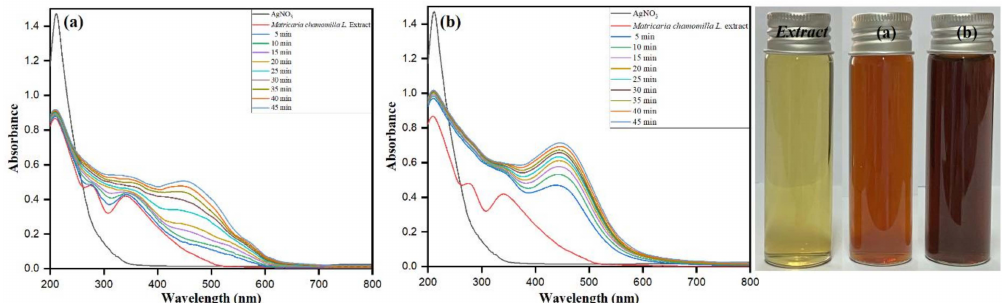
Figure 1. UV–vis absorption spectra of biomolecule-capped AgNPs recorded at 5 min time intervals for 5 to 45 mins ( a ) in bright sunlight ([AgNO 3 = 2.0 mM, [ Matricaria chamomilla L.] = 4%) and ( b ) in dark reaction conditions ([AgNO 3 = 2.0 mM, [ Matricaria chamomilla L.] = 4%). (Optical images of